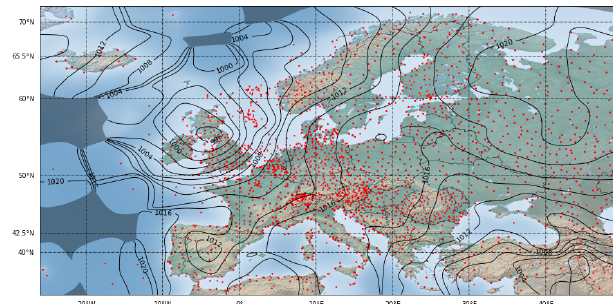
Figure 13. Resulting field from Fig. 12 projected back to a plate carrée map.